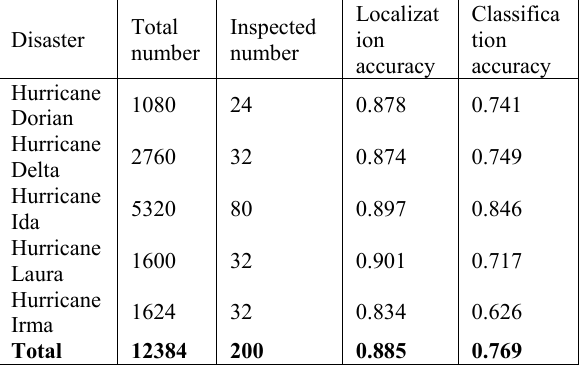
Table 5. Sample library accuracy inspection